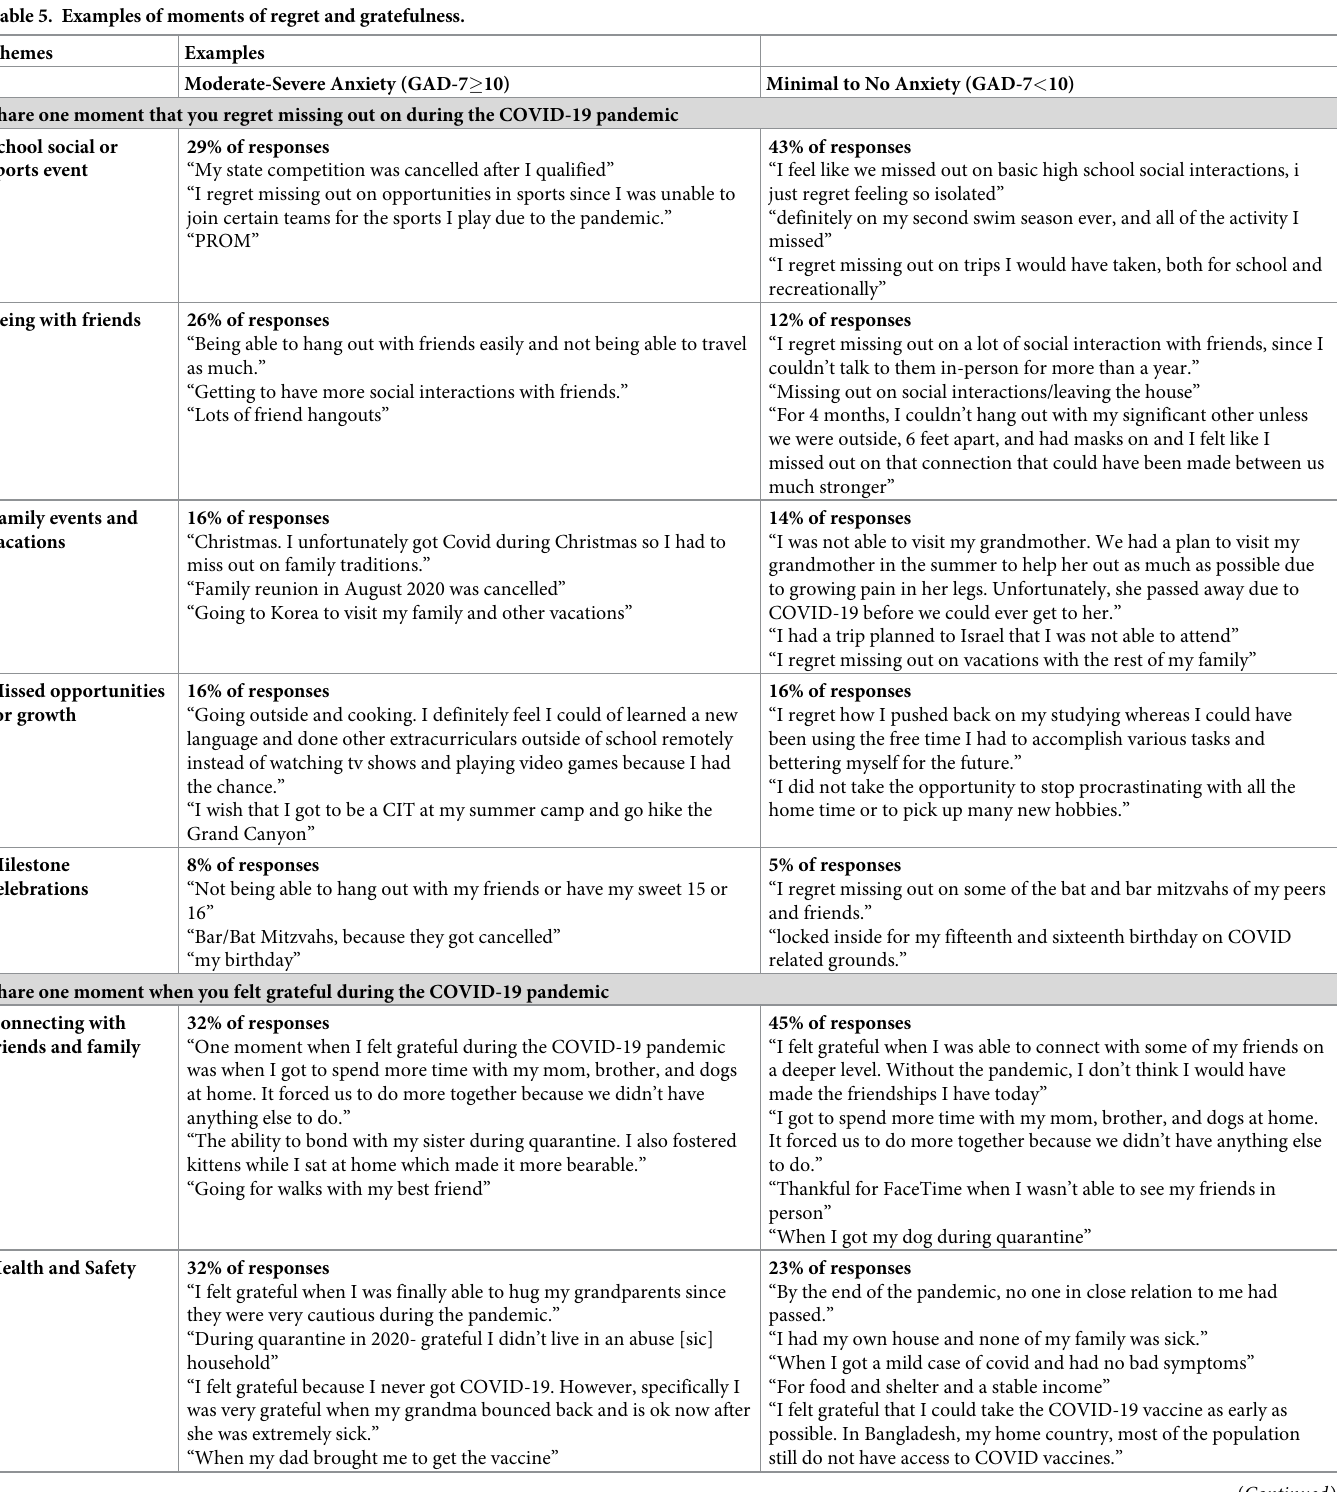
Table 5. Examples of moments of regret and